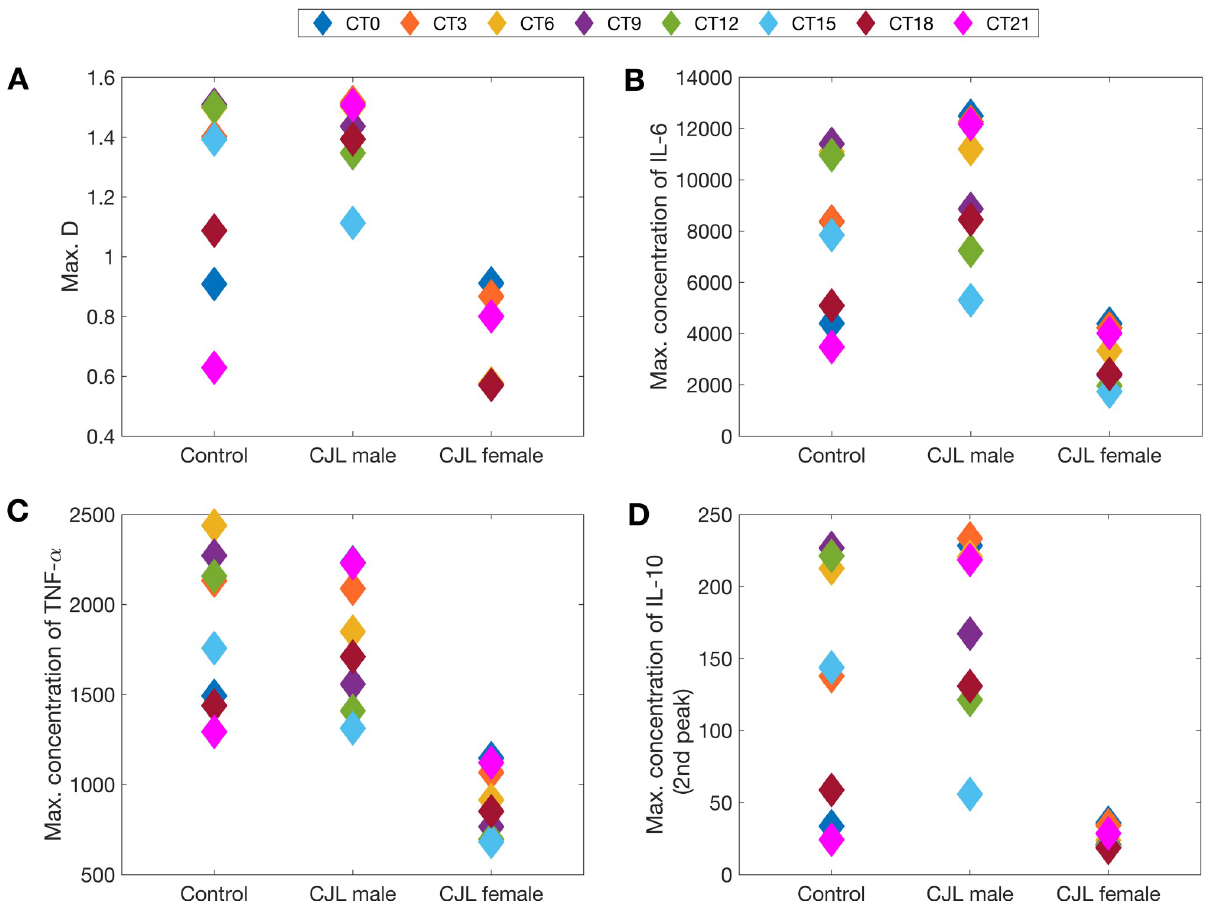
Fig 9. Simulated acute inflammation across different circadian times. IL-6 (A), TNF- α (B), IL-10 (C), Damage marker (D). The endotoxin dose is 3mg/kg. Left column, no CJL; middle column, CJL females; right column, CJL males.